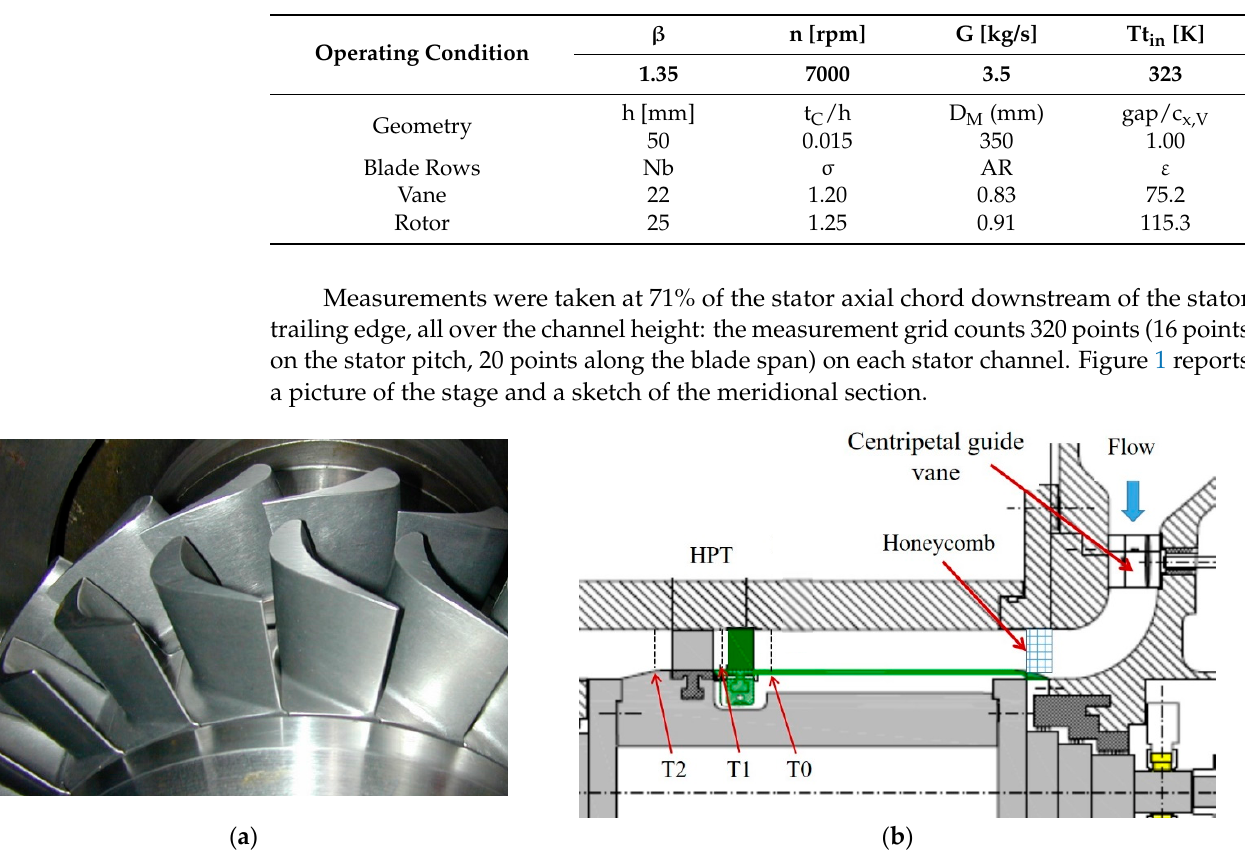
Table 1. Stage geometry and operating conditions.